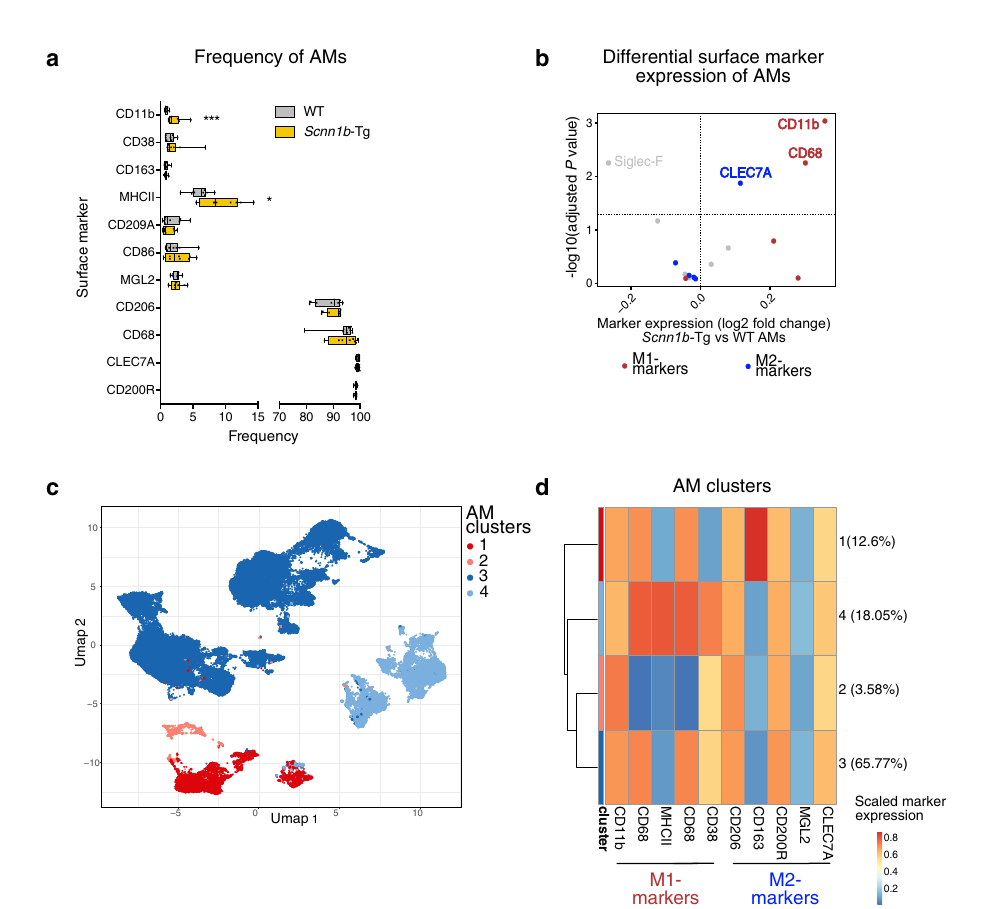
Fig. 3 Single-cell analysis of macrophage surface marker expression validates enhanced activation of Scnn1b -Tg AMs. a Frequency of indicated surface markers expressed by airway macrophages (AM). b Differential surface marker expression of Scnn1b -transgenic (Tg) vs. wild-type (WT) AMs, de fi ned by cluster analysis. Red dots: surface markers for classical macrophage polarization (M1); blue dots: surface markers for alternative macrophage polarization (M2). c Uniform Manifold Approximation and Projection (UMAP) of 50,000 randomly sampled Scnn1b -Tg and WT AMs. d Scaled M1 and M2 surface marker expression of AM clusters. Box plots indicate the largest value within the 1.5× interquartile range above 75th percentile, 75th percentile, median, 25th percentile, and smallest value within the 1.5× interquartile range below 25th percentile of a n = 10 per group. * P value < 0.05; ** P value < 0.01; *** P value < 0.001 by Mann – Whitney U -test. CD11b, P < 0.001; MHCII, P = 0.0185. Source data are provided as a Source Data fi AM-speci fi c functions are impaired in Scnn1b -Tg mice . In abundance of cluster 4 and a decrease in cluster 3 was observed in Scnn1b -Tg lungs (Supplementary Fig. 4d). Together, these results chronic airway in fl ammation, the clearance of apoptotic cells by indicate a mixed phenotype of AMs, in contrast to an exclusive efferocytosis is central to prevent secondary necrosis and the classi fi cation in pro-in fl ammatory (M1) or anti-in fl ammatory release of danger-associated molecular patterns from dying cells 51 . (M2) macrophage functions. We, therefore, analyzed the efferocytosis capacities of Scnn1b -Tg